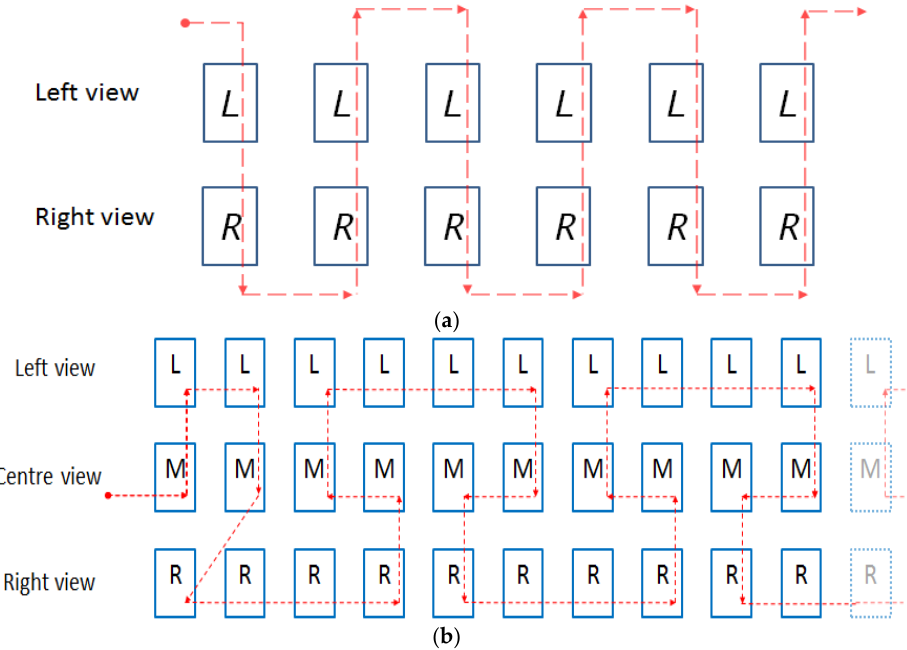
Figure 1. Stereo and multiview frame interleaving block diagram: ( a ) Algorithm’s contour to interleave stereo frames and ( b ) Interleave representation of the stereo frames.